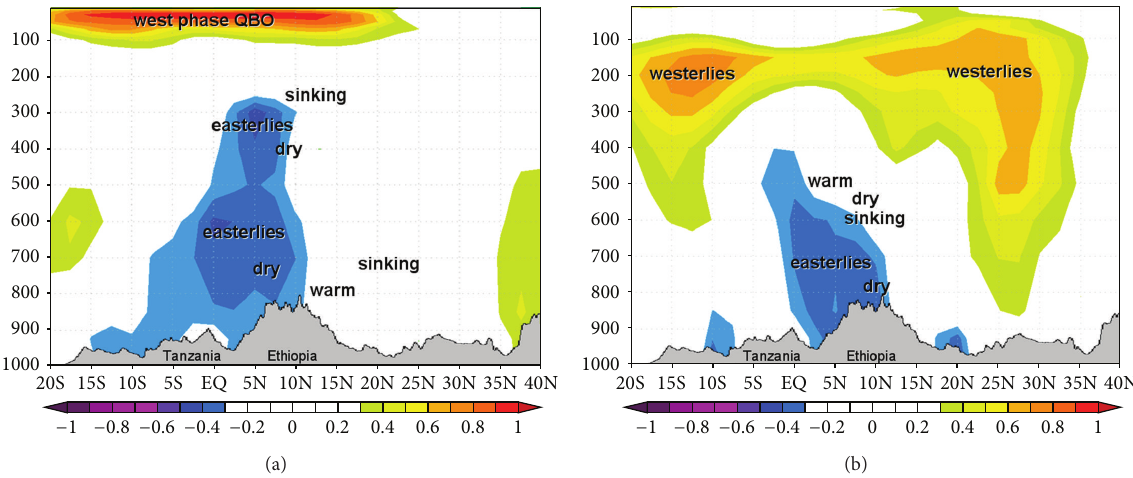
Figure 6: Correlation of JJA zonal winds with (a) QBO and (b) ENSO indices, averaged over the highlands represented as a north-south slice (longitudes 35–40E). Secondary correlations with temperature, humidity, and vertical motion are labeled at the peak value. 𝑧 -axis is the pressure in mb, land surface illustrated with country labels, and values < 0.3 masked.